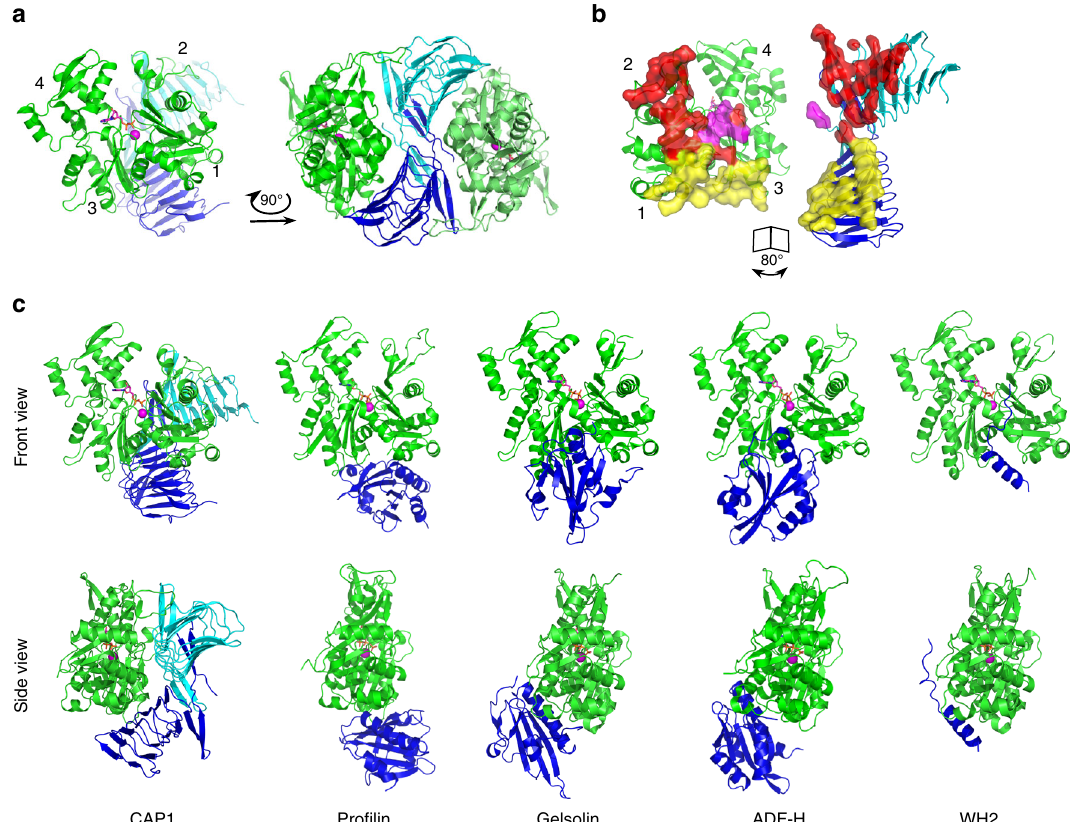
Fig. 1 Crystal structure of the CARP domain from mouse CAP1 in complex with ADP-actin. a CARP domain forms a homodimer (the subunits are in blue and cyan) that binds two actin molecules (in green) through their subdomains 1, 2, and 3. b The CARP domain dimer covers a large surface (1944 Å 2 ) on each actin monomers. The two subunits of the CARP domain dimer employ two different interfaces (primary interface in yellow; secondary interface in red; and C-terminal tail of CARP from the secondary interface in magenta) for association with each actin monomer. c Structural comparison of actin monomer- binding mechanisms of CARP domain of CAP1 (6fm2), pro fi lin (2btf) 44 , gelsolin segment-1 (1eqy) 45 , ADF-H domain of twin fi lin (3daw) 46 , and WH2 domain of ciboulot (1sqk) 47 . Front and side views of the complexes are shown. PDB entries are indicated in